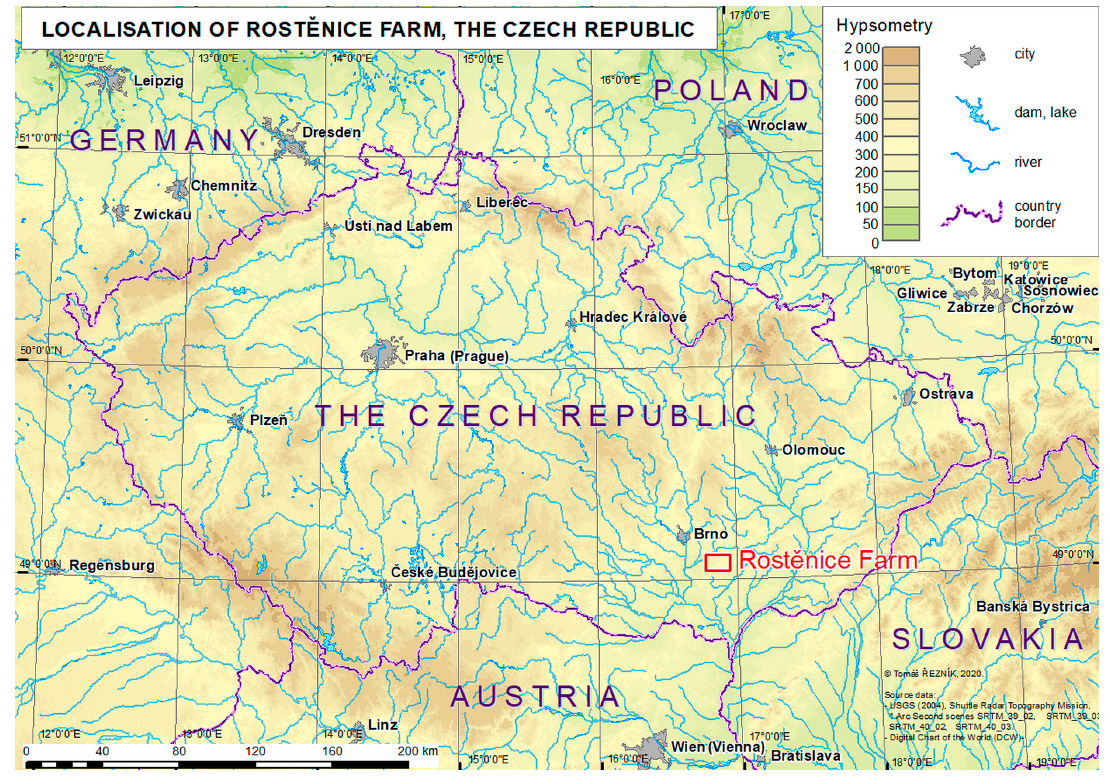
Figure 2. Geographical location of the Rost ě nice Farm.